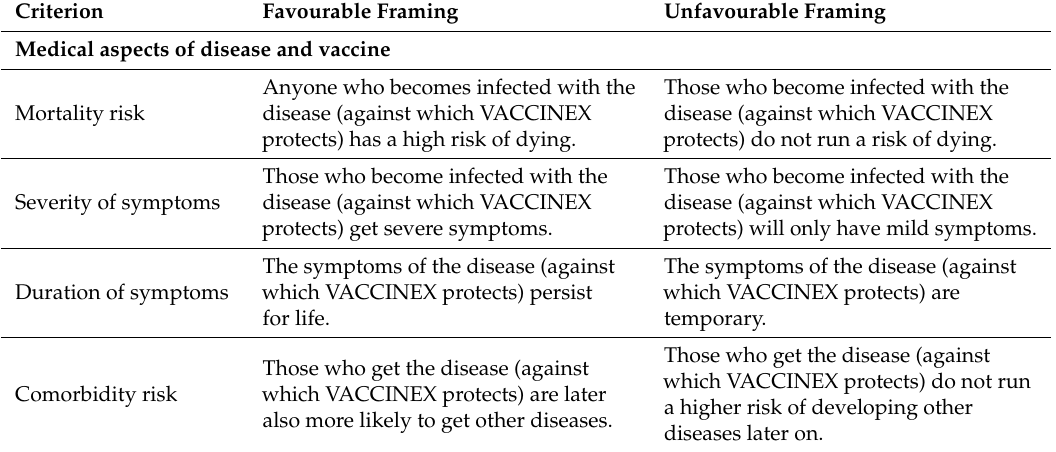
Table 1. Value propositions, favourably and unfavourably